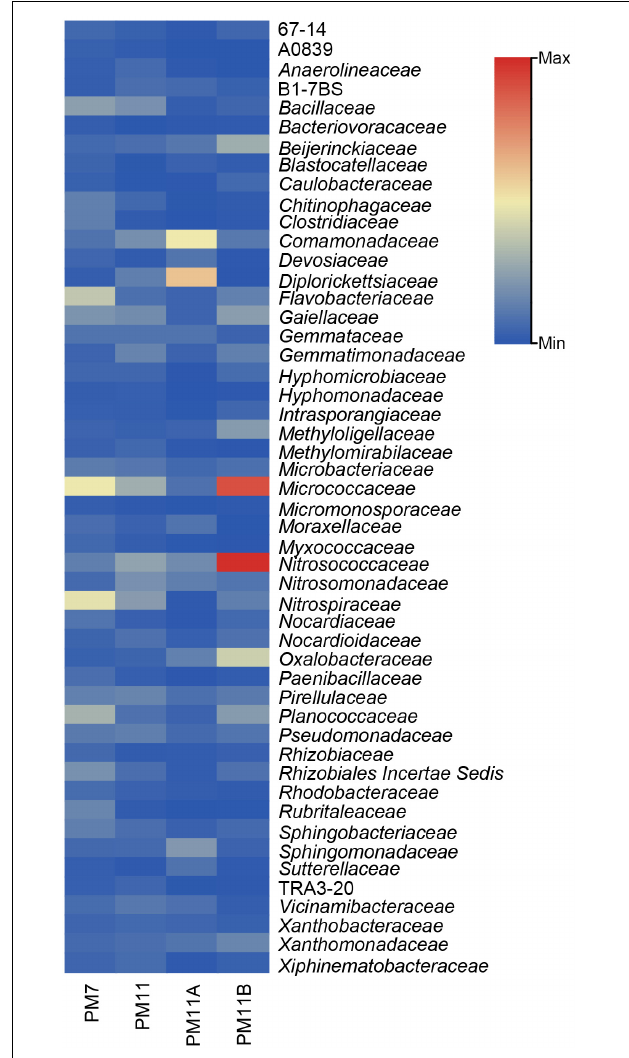
FIGURE 4 | Heatmap of the relative abundance (only > 1% are represented) of bacterial families in the sediment and crust samples of Muierilor Cave.